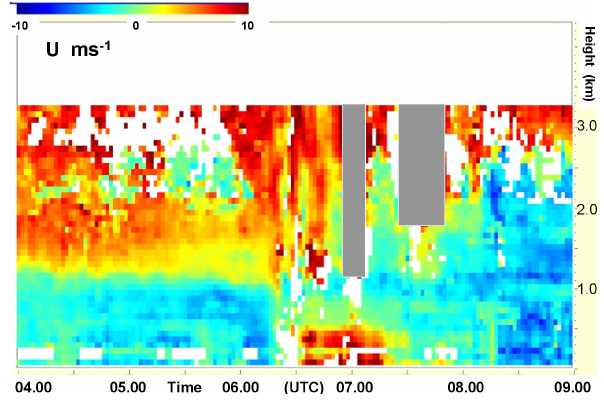
Fig. 4c. Range corrected signal to noise ratio in dB measured by the wind profiler at Linkenholt 24 June 2005, 04:00 to 09:00UTC from 75 to 3250m a.g.l.